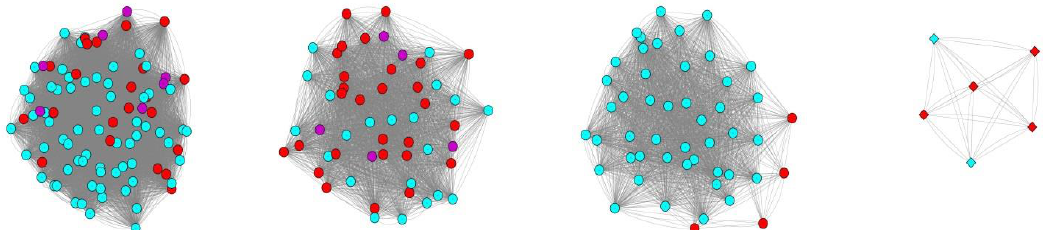
Figure 6. Comparison of proteins of nitrogenase beta subunit in methanotrophic bacteria. The nitrogenase complexes of methanotrophic bacteria clustered in 4 independent groups according to the level of amino acid identity. Edges denote amino acid identity of two proteins greater than 50%. Mo-Fe nitrogenases are indicated by circles, V-Fe nitrogenases – by diamonds. Nitrogenases from members of the family Methylocystaceae are colored in red; Methylococcaceae – in cyan; Beijerinkiaceae – in purple.